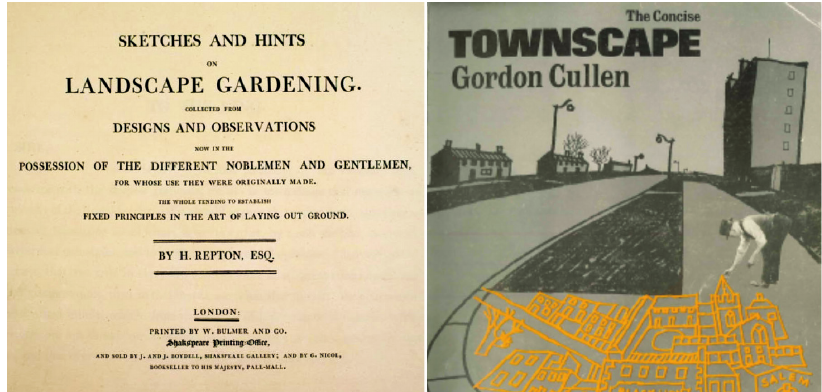
Figure 4. Repton, title page of Sketches and Hints on Landscape Gardening (1794) (left). Public domain; Cullen, book cover, The Concise Townscape (1971) (right). Reproduced by permission of Taylor & Francis Books,